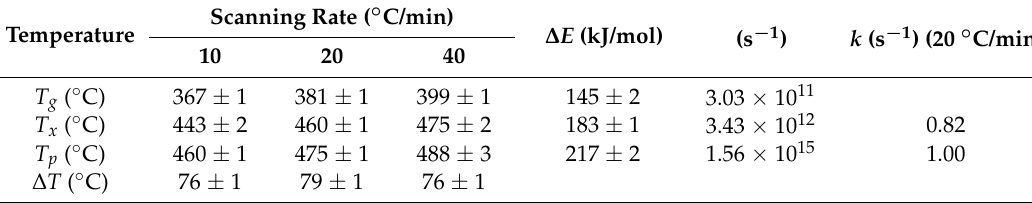
Table 2. The characteristic temperatures, activation energy, and crystallization constant after 1 h.